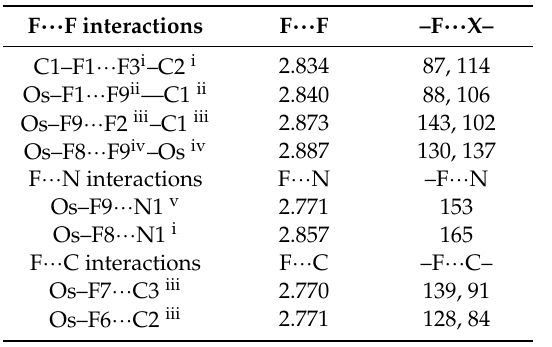
Figure 4. F···F, F···N, and F···C interactions (depicted as dotted and dashed lines) assemble the molecular complexes into a supramolecular three-dimensional network. Table 3. Halogen bond geometry (Å, °).